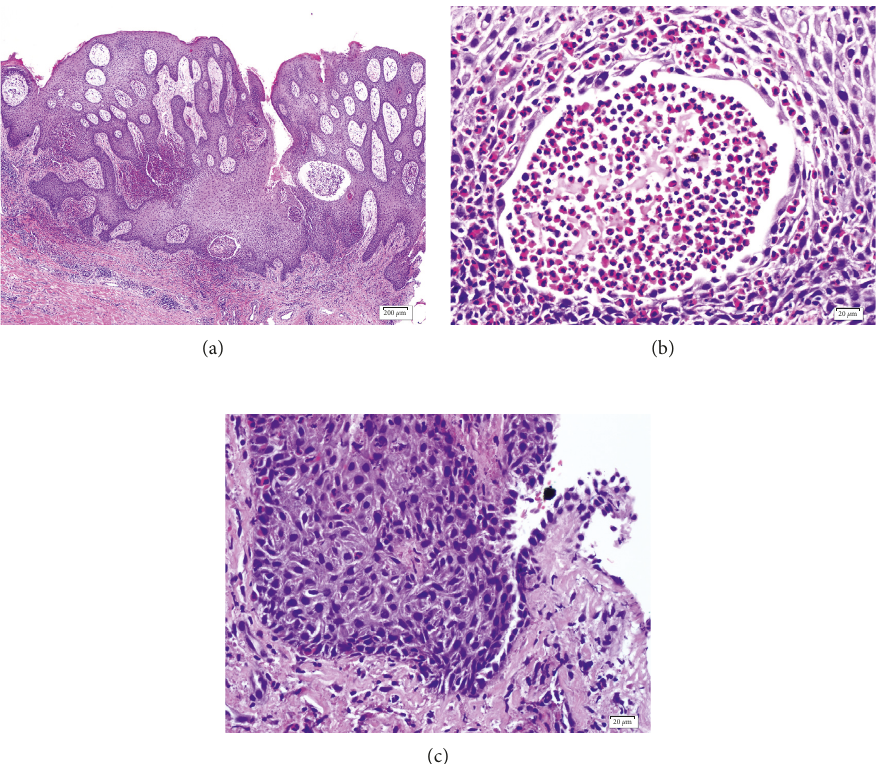
Figure 2: Histopathology study (hematoxylin and eosin staining) demonstrated pseudoepitheliomatous hyperplasia of epidermis with eo- sinophilic spongiosis (a), intraepidermal eosinophilic microabscess with few acantholytic cells (b), and focal area of suprabasal separation